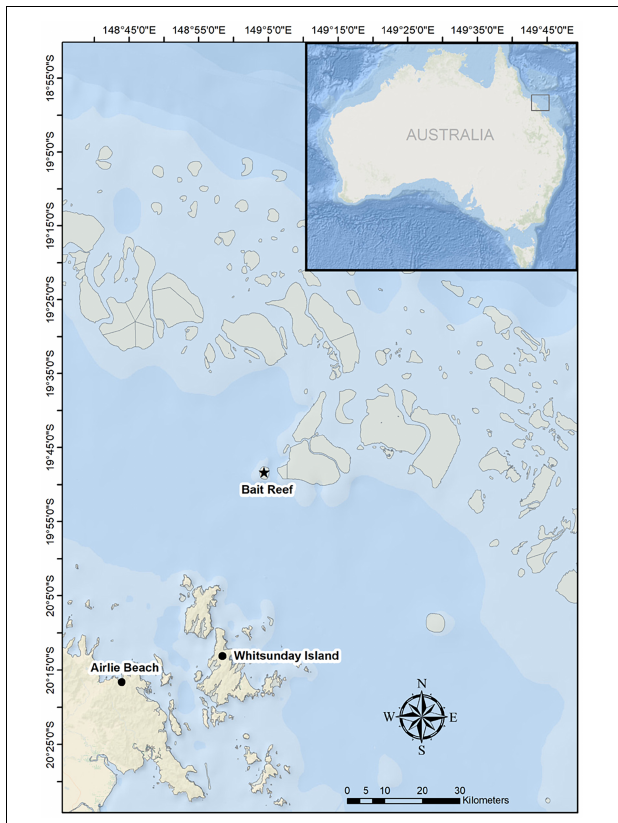
FIGURE 1 | Map of the study area in the Great Barrier Reef, indicating the primary survey area around Whitsunday Island. The majority of competitive groups were found to the northeast, between Whitsunday Island and Bait